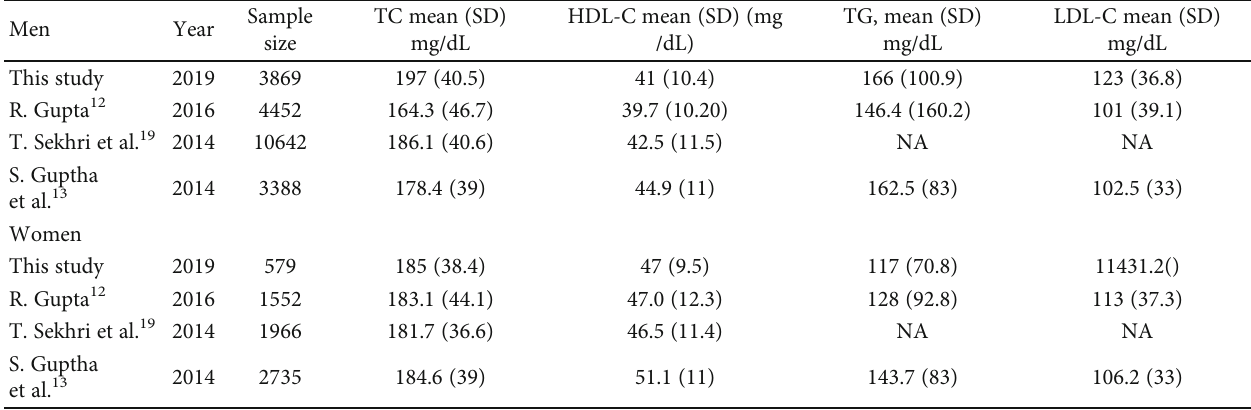
(b) Comparison of prevalence of dyslipidemia among Indian expatriates in Qatar with other studies on Indians